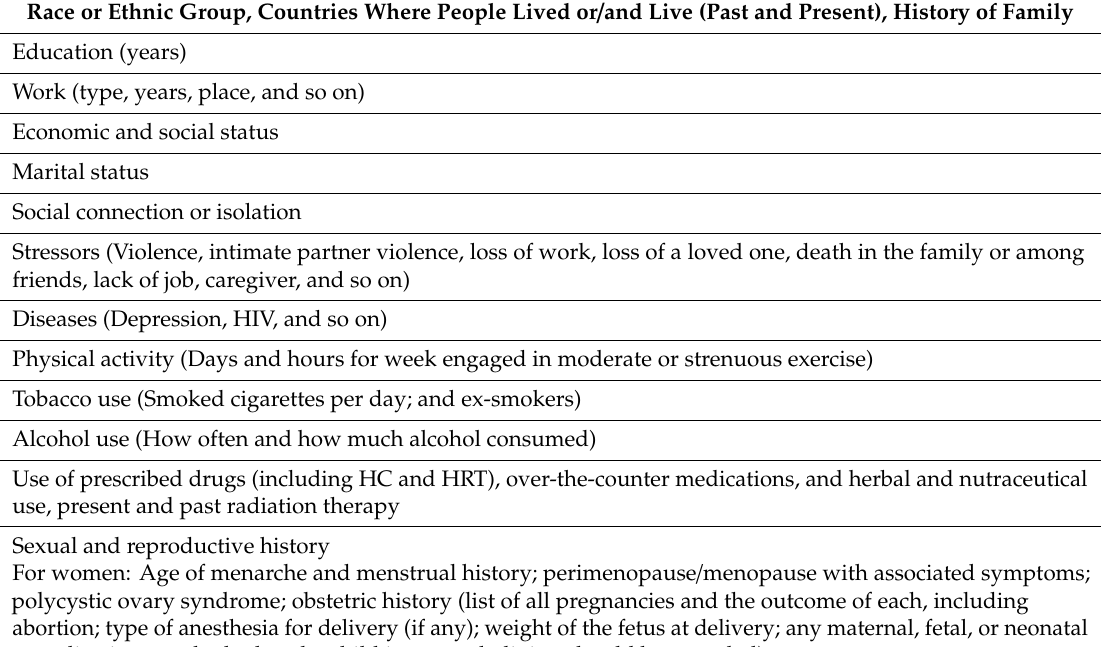
Table 2. Minimum social and behavioral factors that should be recorded in a patient bibliography. Race or Ethnic Group, Countries Where People Lived or / and Live (Past and Present), History of